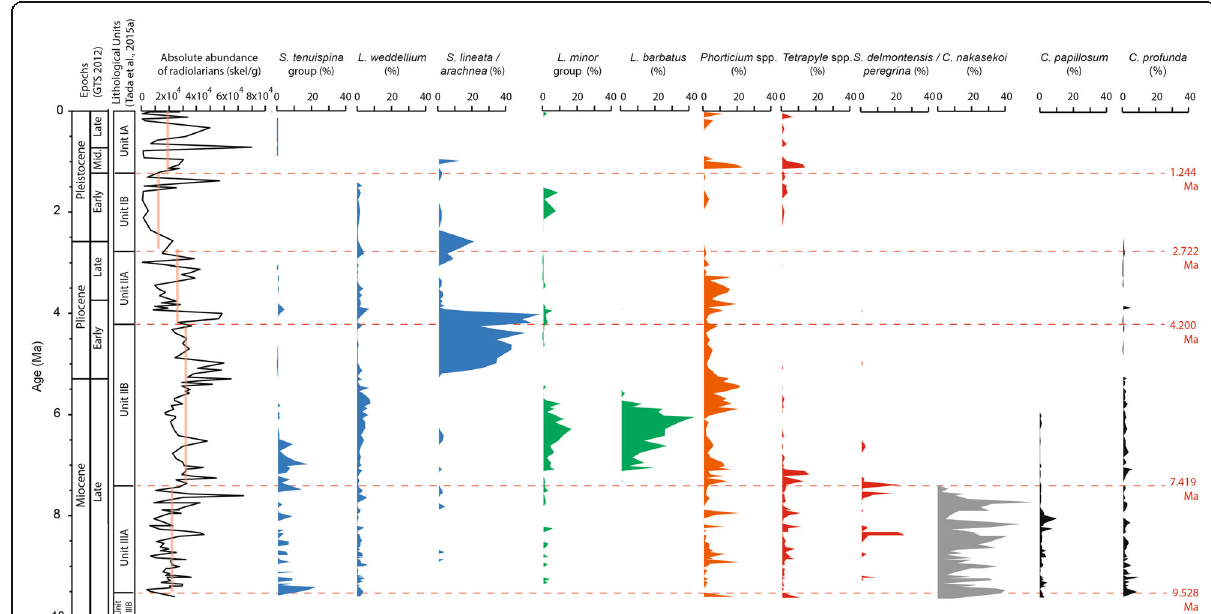
Fig. 4 Radiolarian absolute abundance (AB) (skel/g) and relative abundance (%) of selected radiolarian species (2/2) at Site U1425 plotted by age (Ma) (Kamikuri et al. 2017 depth age model) and compared to the lithological units of Tada et al. (2015a). Narrow red shading on the AB curve corresponds to the mean AB for each lithological